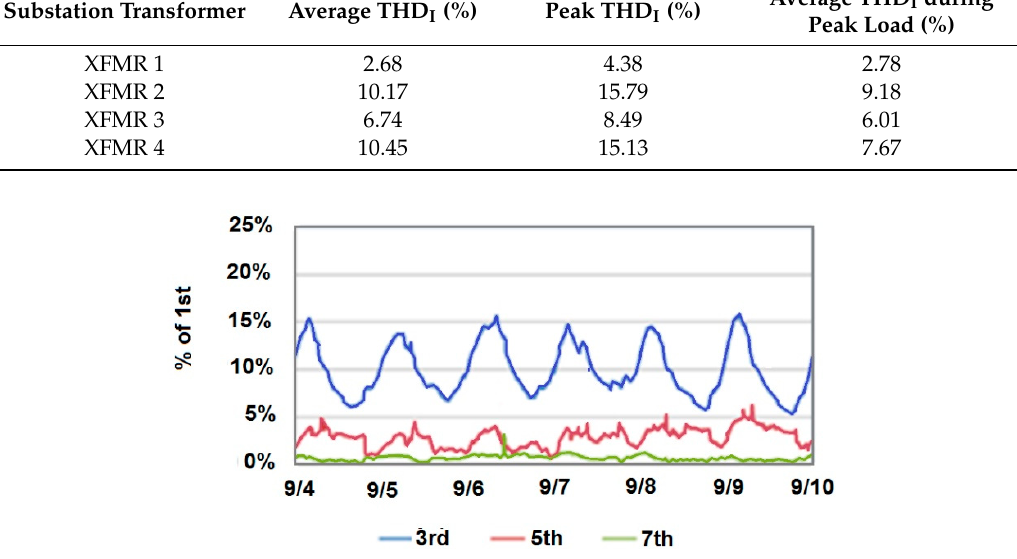
Figure 4. Current harmonic spectrum for XFMR 4. Table 1. Harmonic voltage monitoring results.